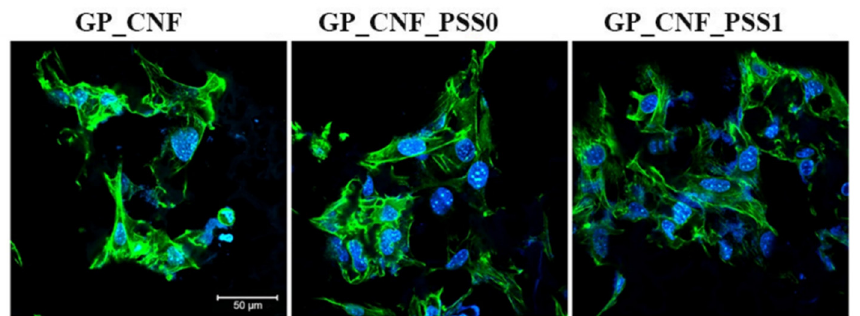
Figure 7. Cytoskeleton developed by murine preosteoblasts cultivated in contact with GP_CNF, GP_CNF_PSS0 and GP_CNF_PSS1 during 48 h of culture under standard conditions, as revealed by phalloidin-FITC staining coupled with confocal microscopy. The nuclei of cells are stained in blue (Hoechst 33342). Scale bar 50 μm.